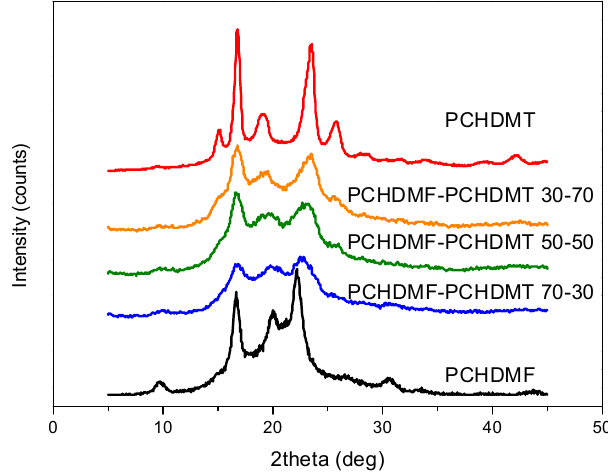
Figure 6. XRD patterns for neat poly(1,4-cyclohenedimethylene furanoate) (PCHDMF), poly(1,4-cycloxehane terephthalate) (PCHDMT), and their blends.